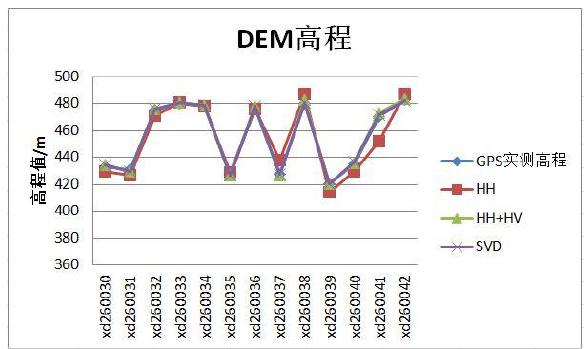
Figure 3. DEM elevation contrast